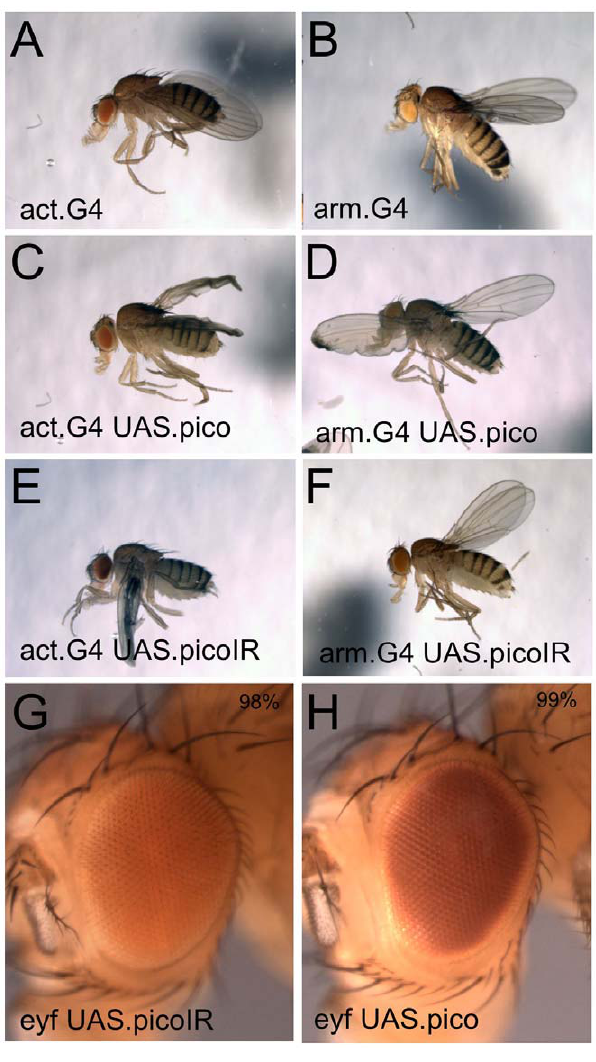
Figure 3. Pico is not required to regulate body size or eye size. (A) A control act.Gal4 fly. (B) A control arm.Gal4 fly. (C) Ubiquitous overexpression of Pico with act.Gal4 does not change body size, but does affect wing morphology. (D) Ubiquitous overexpression of Pico with arm.Gal4 does not change body size, but does affect wing morphology. (E) Ubiquitous RNAi knockdown of Pico with act.Gal4 does not change body size, but does affect wing morphology. (F) Ubiquitous RNAi knockdown of Pico with arm.Gal4 does not change body size, but does affect wing morphology. (G) RNAi knockdown of Pico in the eye with ey.flp act . STOP . Gal4 produces normally sized eyes. (H) Overexpression of Pico in the eye with ey.flp act . STOP . Gal4 produces normally sized eyes.